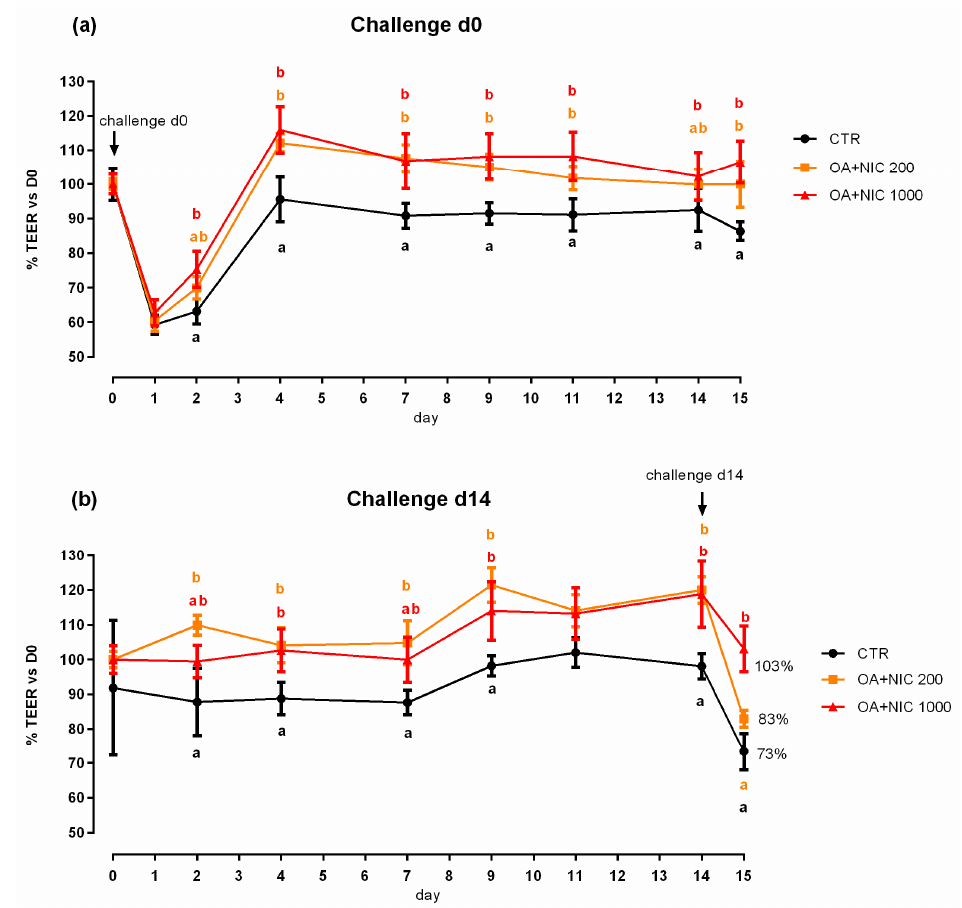
Figure 8. TEER of Caco-2 cells cultured with OA + NIC and subjected to an inflammatory challenge. Data in the graph are represented as percentage of the initial TEER value and given as means ( n = 6) ± SEM, represented by vertical bars. Means with different letters indicate statistical significance with p < 0.05 (a, b); means with at least one common letter are not significantly different (ab), colors of the letters refer to the different treatments. TEER = transepithelial electrical resistance ( Ω ·cm 2 ); CTR = control group; OA + NIC 200 = treated group with 200 ppm of OA + NIC, composed from 260 µM of citric acid, 298 µM of sorbic acid, 23 µM of thymol, and 13 µM of vanillin; OA + NIC 1000 = treated group with 1000 ppm of OA + NIC, composed from 1300 µM of citric acid, 1490 µM of sorbic acid, 110 µM of thymol, and 70 µM of vanillin. ( a ) Cells challenged at day 0 of the study. ( b ) Cell challenged at day 14 of the study.